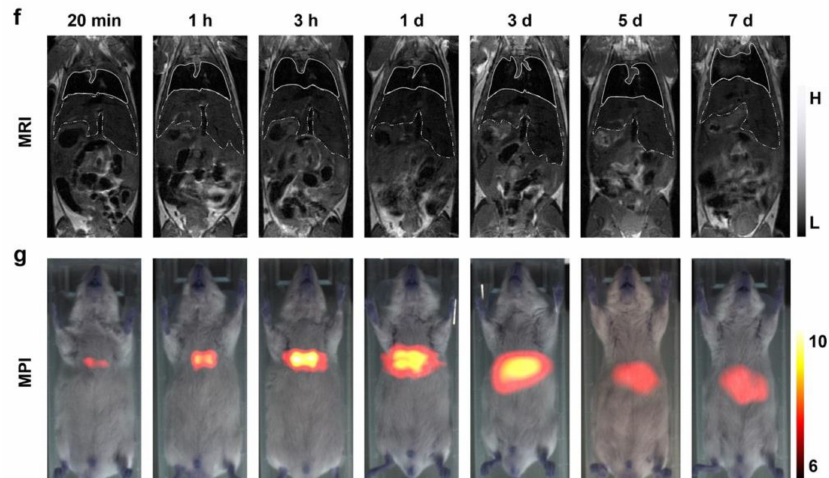
Figure 1. In vivo experiments that used MPI to track di ff erent numbers of stem cells injected subcutaneously (s.c.) into mice. The cells were labeled with the MPI-tailored tracer CIONs-22 or VivoTrax. The images are MPI images of a mouse ( a ) injected with 100 K stem cells labeled with CIONs-22, ( b ) injected with 100 K or 5 K stem cells labeled with VivoTrax, ( c ) injected with 5 K or 2.5 K stem cells labeled with CIONs-22, ( d ) 3 h after intravenous (i.v.) injection of 100 K CIONs-22-labeled stem cells and postmortem CIONs-22-labeled stem cell biodistribution 20 min, 3 h, or 7 days after i.v. administration, and ( e ) 3 h after the i.v. injection of 300 K or 100 K VivoTrax-labeled stem cells. ( f ) MRI images of a representative mouse after i.v. injection of 300 K CIONs-22-labeled stem cells. ( g ) Longitudinal 2D projection MPI images of a representative mouse within 1 week after i.v. injection of 100 K CIONs-22-labeled stem cells. Image reproduced, with permission, from Reference